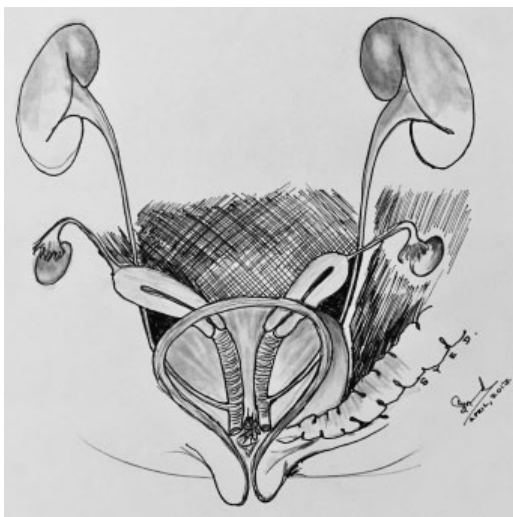
Fig. 1 Common channel 3.5 cm at the second day of life.